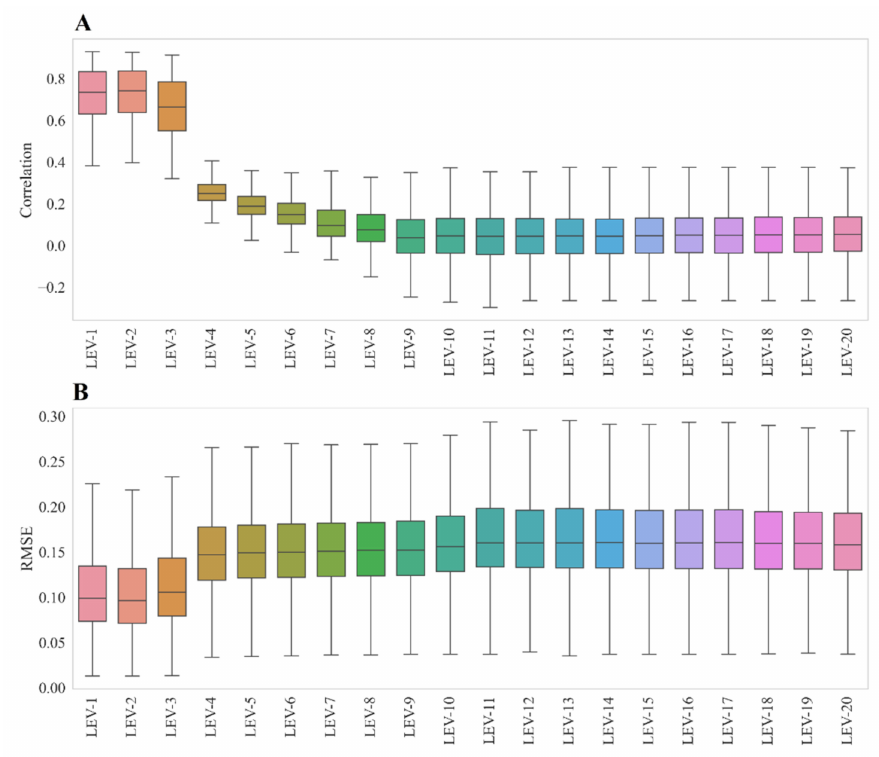
Figure 6. Wavelet denoising results: boxplots of the cross-correlation (CC, panel ( A )) and root mean square error (RMSE, panel ( B )) values between observed and denoised NDVI time series by using different decomposition levels. The AVHRR sensor was selected as example here. The level 2 (in red) exhibited better RMSE (0.096) and correlation (CC = 0.741) compared to